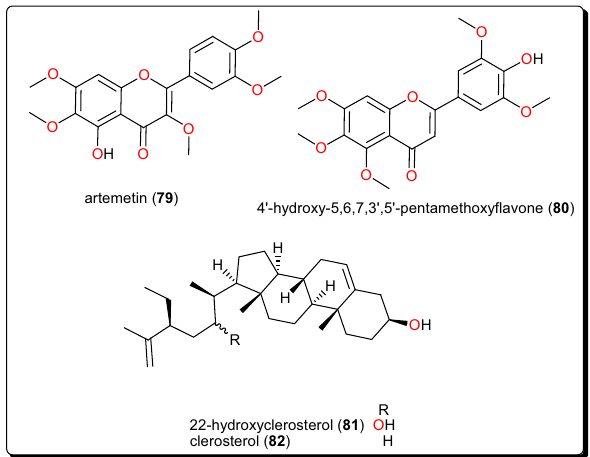
Fig. 15 Flavonoids and phytosterols with trypanocidal